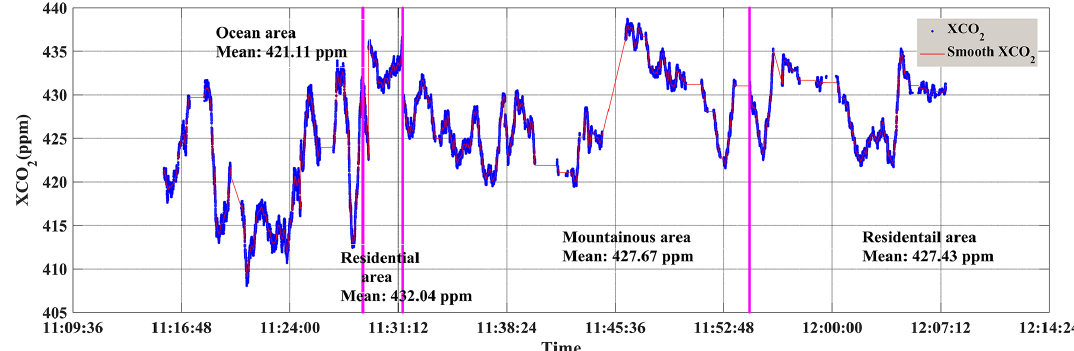
Figure 12. XCO 2 results over ocean, urban residential, and mountainous areas on 14 March 2019. The purplish red vertical line represents the boundary of different surface types.